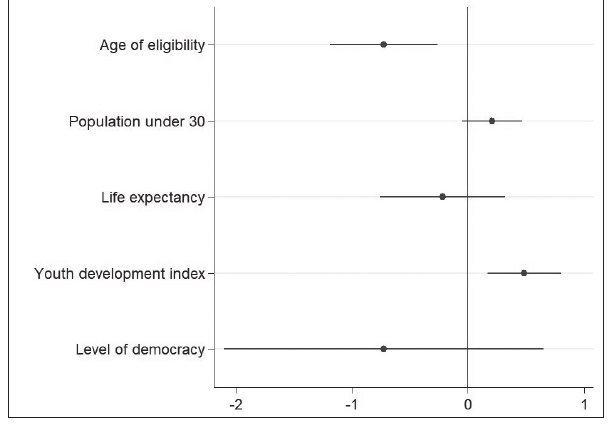
Figure 6: Regression coefficients and confidence